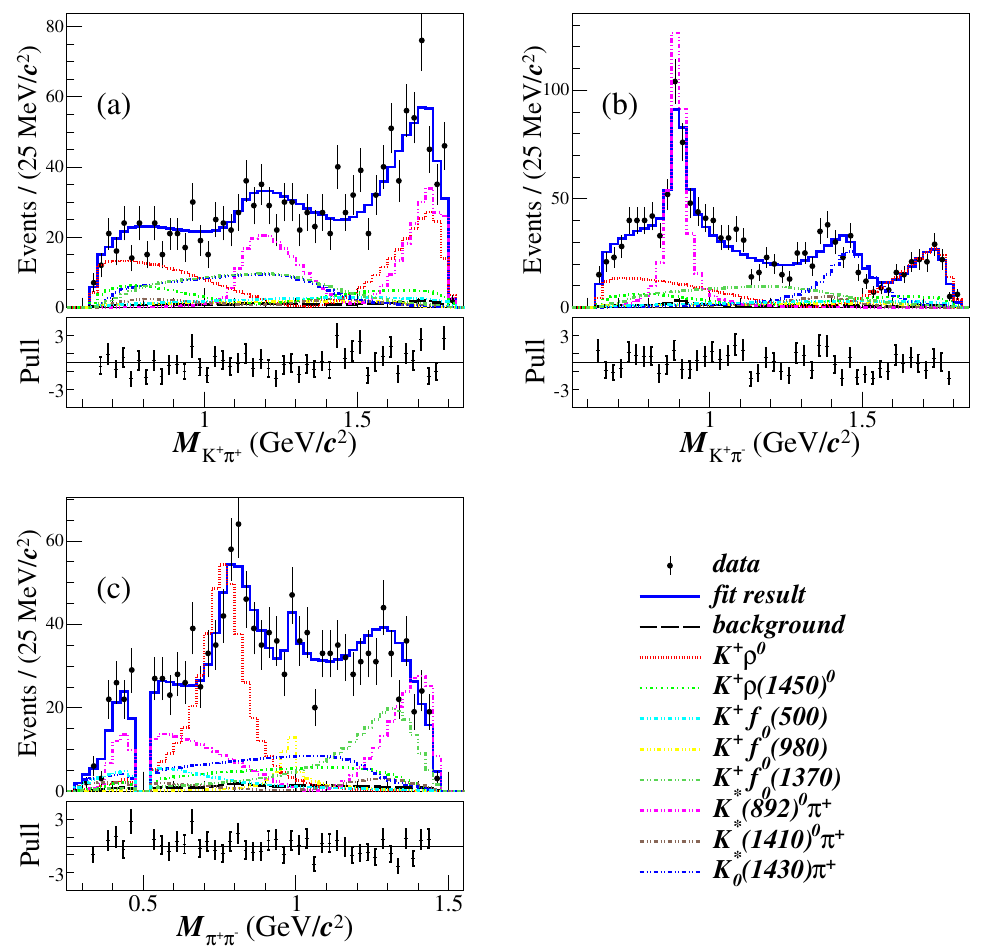
, (b) M , and (c) M of the nominal fit. The Figure 3 . The projections on (a) M K + π + K + π − π + π − √ data samples at s = 4 . 178 − 4 . 226 GeV are represented by points with error bars, the fit results by the solid blue lines, and the background estimated from the inclusive MC samples by the black dashed lines. Colored curves show the components of the fit model. Due to interference effects, the total is not necessarily equal to the linear sum of the components. Pull projections are shown beneath each distribution; if there are less than 10 events in a bin, that bin is merged with the next bin until the number of events is larger than or equal to